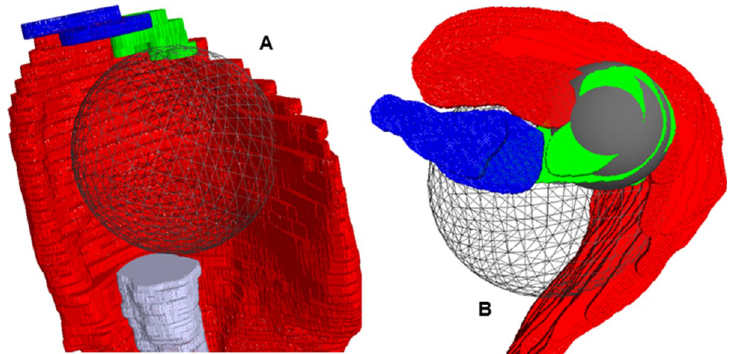
Fig 3. Positioning of the least square spheres (ILSS and acromion). (A) A mesh sphere is created which allows manual point selection on the internal aspect of the MD: its size (radius ILSS) and position are adjusted manually in the 3D model, as close to the desired position as possible. (B) The grey sphere is the 2 nd least squared sphere going through the acromion to find Point 1.